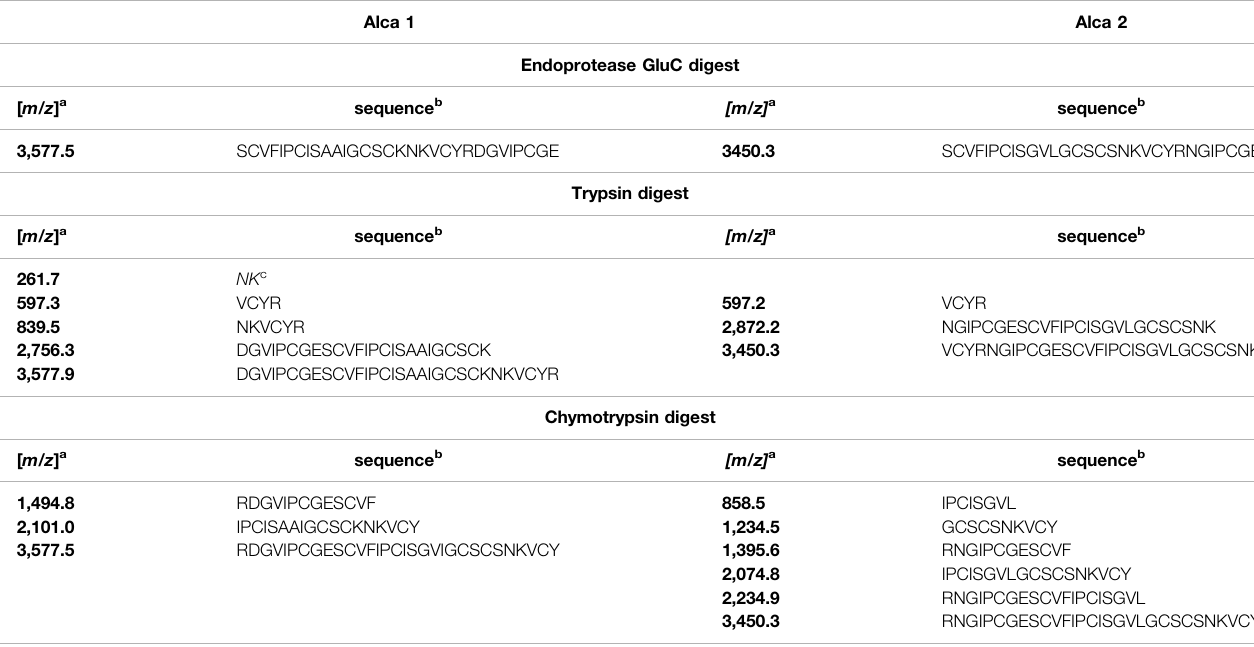
TABLE 2 | Endoprotease GluC, tryptic and chymotryptic fragments of alca 1 and alca